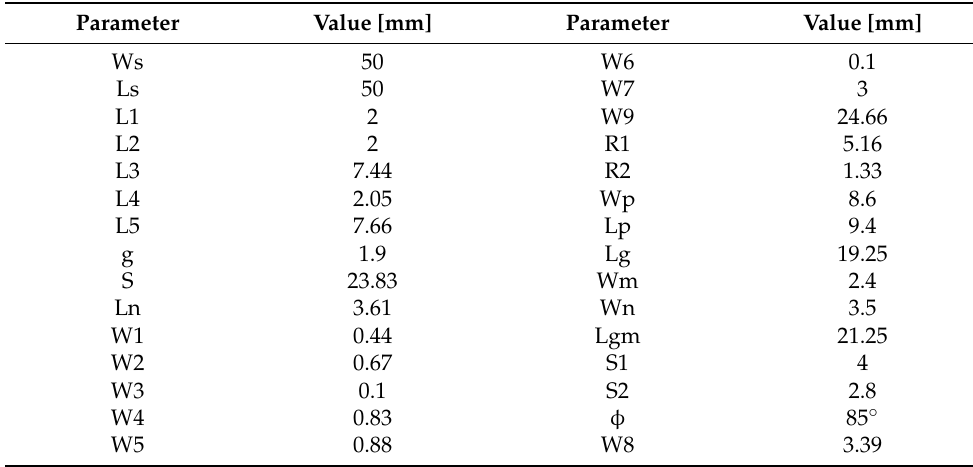
Figure 10. Geometry of the integrated UWB antenna array with the single-wing bandpass filter: ( a ) Front view, ( b ) Back view. Table 4. Design parameters of the UWB filtering antenna array.